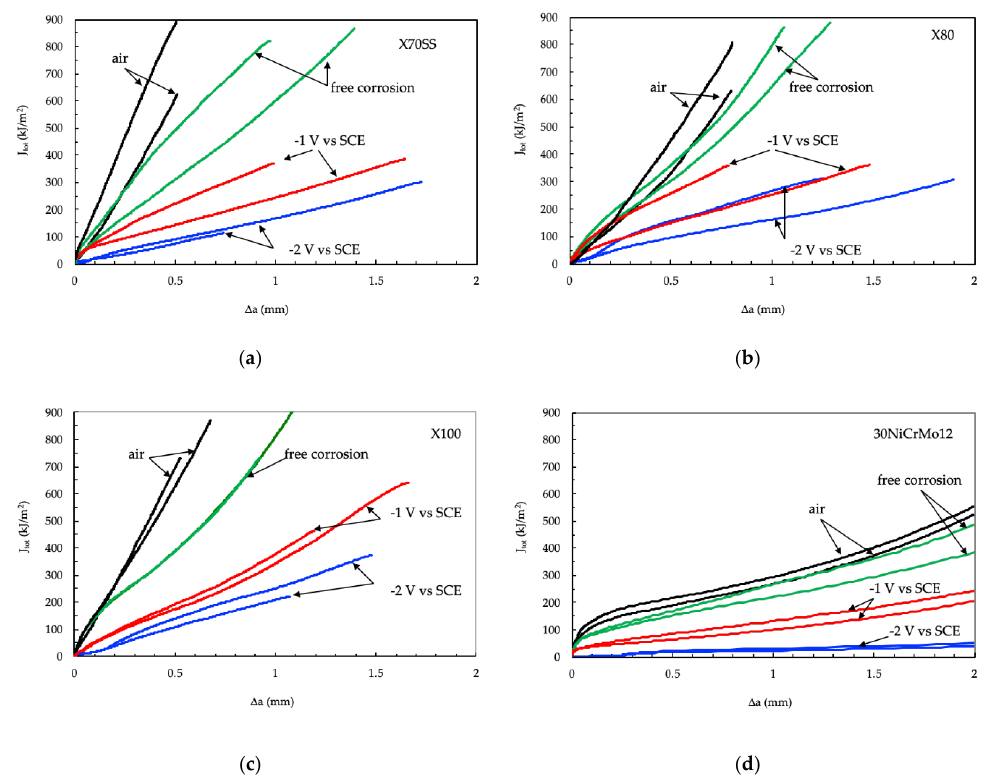
Figure 4. Results of J-integral tests. ( a ) X70SS steel; ( b ) X80 steel; ( c ) X100 steel; ( d ) 30NiCrMo12 steel.